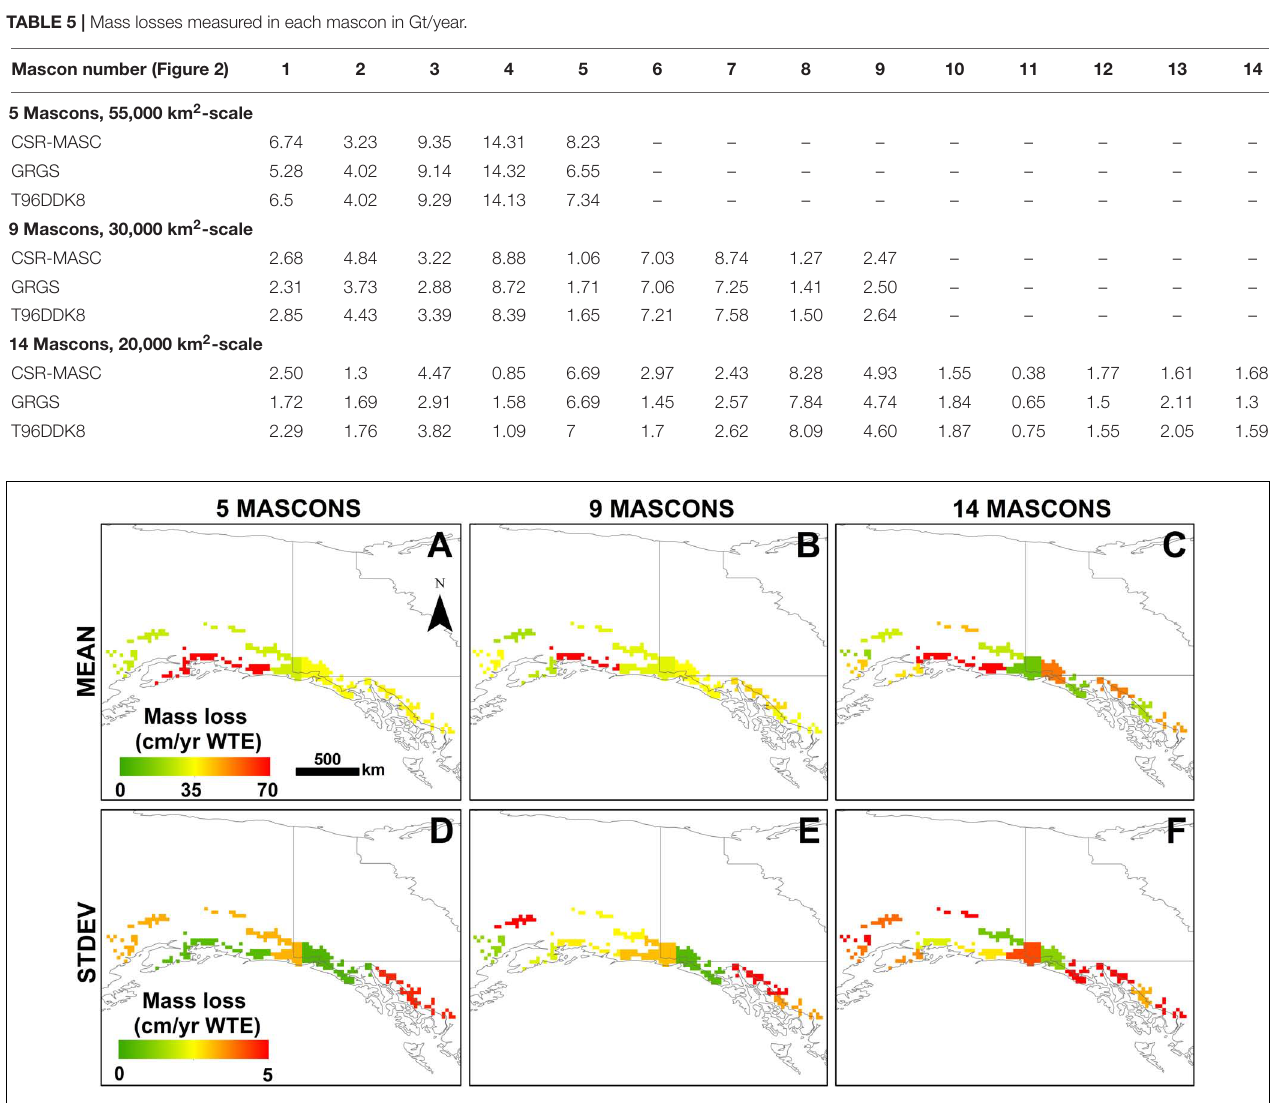
FIGURE 6 | High resolution mapping according to the three mass distribution scenarios ( Figure 2 ): mean mass loss (A–C) and standard deviation (D–F) . Maps are presented in order of focusing resolution: (A–D) 5-, ( B–E) 9-, and (C–F) 14-mascon delineations. Two different scales of the same color maps are used for A – C and D – F